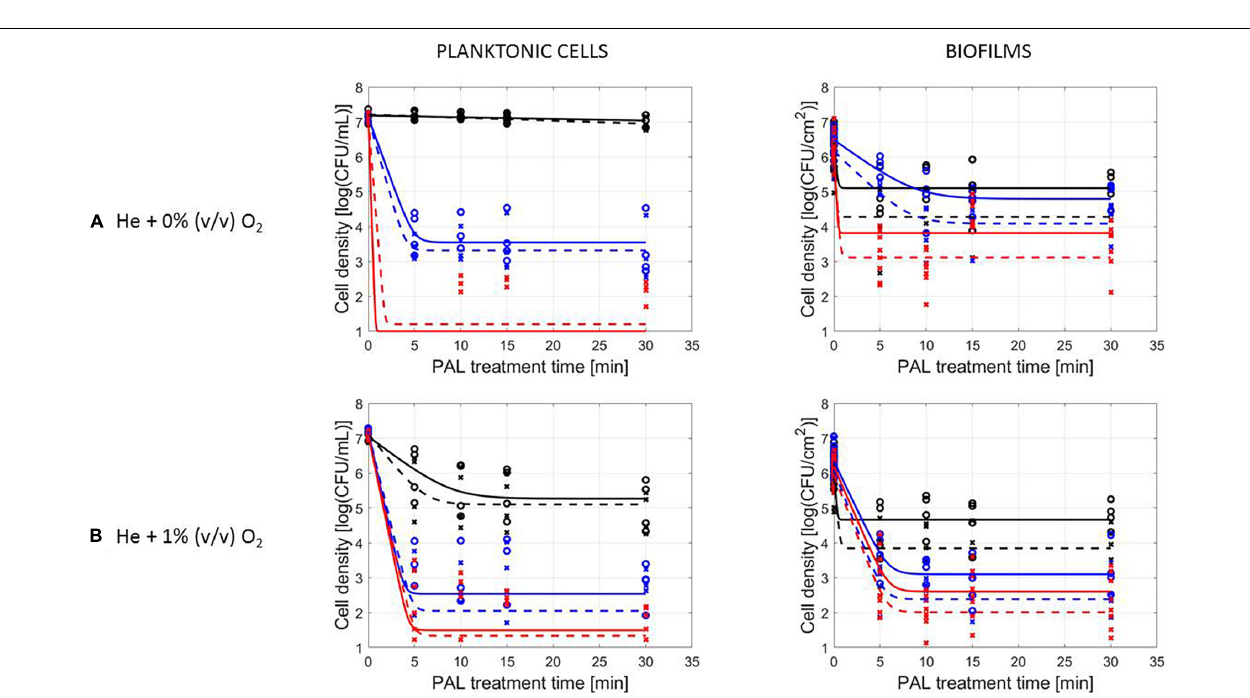
Frontiers in Microbiology |